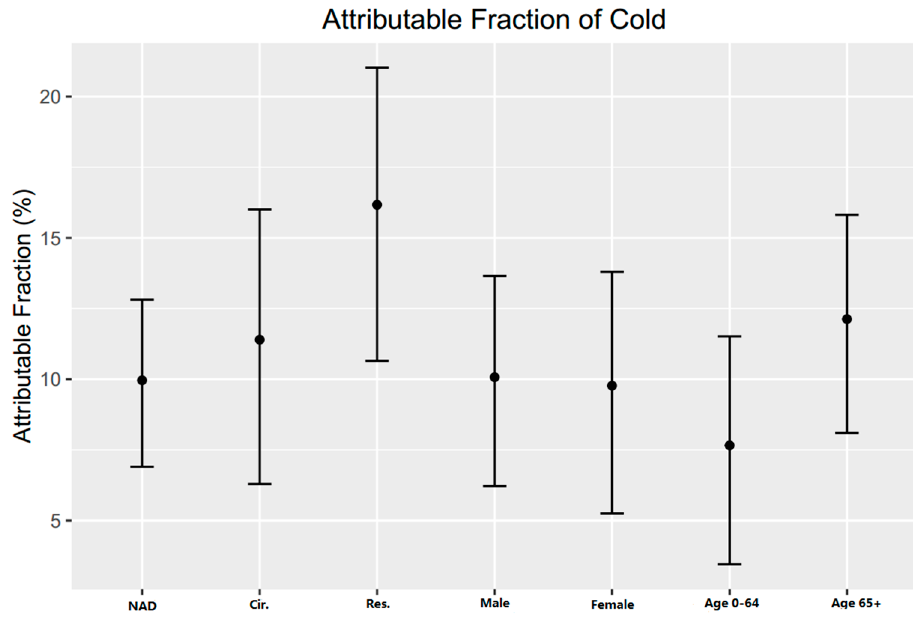
Figure 4. Attributable fraction of cold for different disease causes, sex and age group. NAD = non-accidental disease, cir. = cardiovascular disease, res. = respiratory disease.